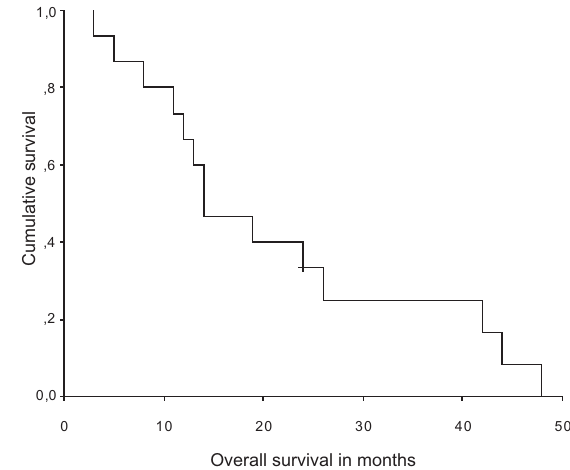
Fig. 1. Overall survival of the patients enrolled in the